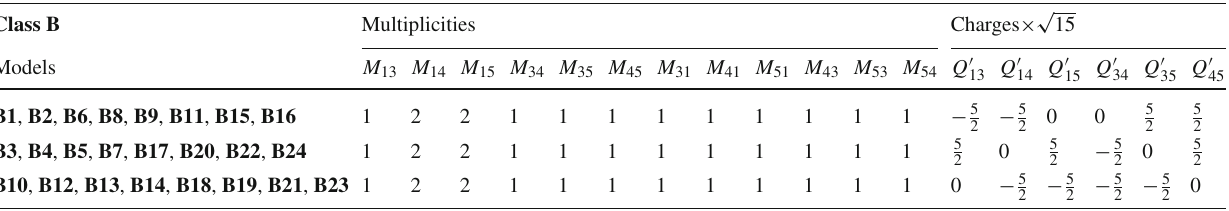
Table 12 Singlets spectrum of Class B